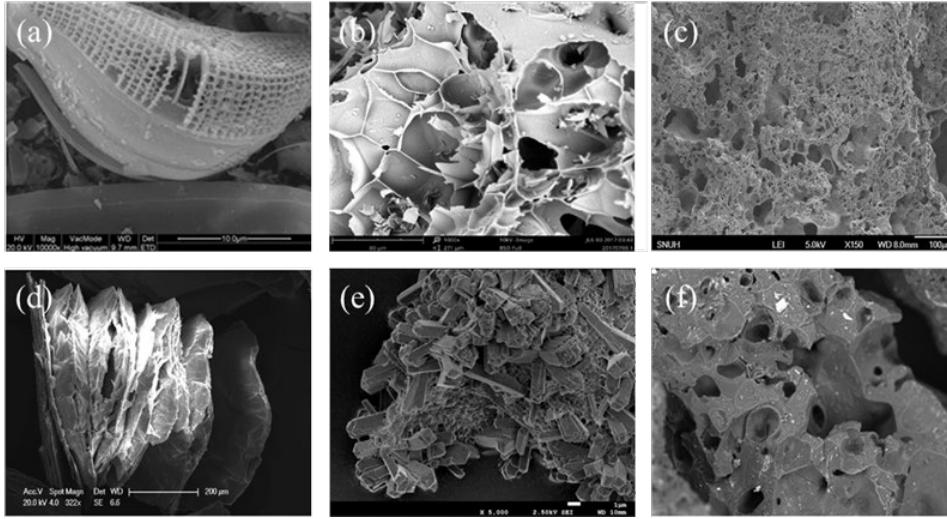
Figure 3. The microstructure of different materials: ( a ) diatomite [46]; ( b ) expanded perlite [42]; ( c ) expanded clay [43]; ( d ) expanded vermiculite [45]; ( e ) zeolite [47]; ( f ) granular activated carbon [48]. Zhang et al. [7] adsorbed microorganisms into EP and EC, respectively, using a vac- uum impregnation method. EP and EC have high porosity and high water absorption, once cracks appear in the concrete matrix, the high porosity structure can provide enough oxygen to the immobilized bacteria in the concrete and the high water absorption can expose the bacteria to sufficient water. After specimens with cracks were cured under 20 ± 2 ℃ and 95% humidity for 28 d, the healing width of concrete cracks mixed with EP particles was 0.79 mm, whereas the healing width of those mixed with EC particles was only 0.45 mm. EP particles had higher bacterial content, lower incorporation, and better crack healing than EC particles. Similarly, using the vacuum impregnation immobiliza- tion method, Boon et al. [8] evaluated two carriers, EC and GAC, and showed that the latter had a larger range of crack healing widths and a higher healing limit. Huynh et al. [6] also obtained good crack self-healing using DE-immobilized microorganisms with a maximum crack self-healing width of 1.8 mm. Bhaskar et al. [44] and Zhan et al. [45] investigated the effects of immobilized micro- organisms on the mechanical properties of cement-based materials using zeolite and EV as carrier materials, respectively. The results showed that the microorganisms protected by the carriers remained highly active in a high-pH environment. The mineralized depos- ited calcium carbonate continuously filled the mortar pores and tiny cracks, and the com- pressive strength of the specimens containing immobilized microorganisms was signifi- cantly increased compared with the control specimens without adding carriers and bac- teria at a certain carrier admixture and before cracking. The particle size of ceramsite (an EC) is generally less than 5 mm, and the tempera- ture influences its porosity. In the range of 400 °C to 800 °C, small pores fuse into large pores, and swelling occurs. When the temperature increases further, the viscosity de- creases excessively, causing shrinkage and condensation of sintering products and a re- duction in porosity [49]. To load the ceramsite with more microorganisms, XU et al. [50] improved the porosity of the ceramsite by heat treatment and noted that the ceramsite had the highest loading at a heating temperature of 750°C. In addition, in a study of crack self-healing, they found that, compared with the control group without adding carriers and bacteria, the compressive strength of the bacterial test group protected by ceramsite increased by over 20%, the water absorption rate decreased by about 30%, the healing rate of cracks reached 86%, and the maximum healing width of cracks was 0.3 mm. This is because ceramsite can provide a good living environment for ureolytic bacteria, which